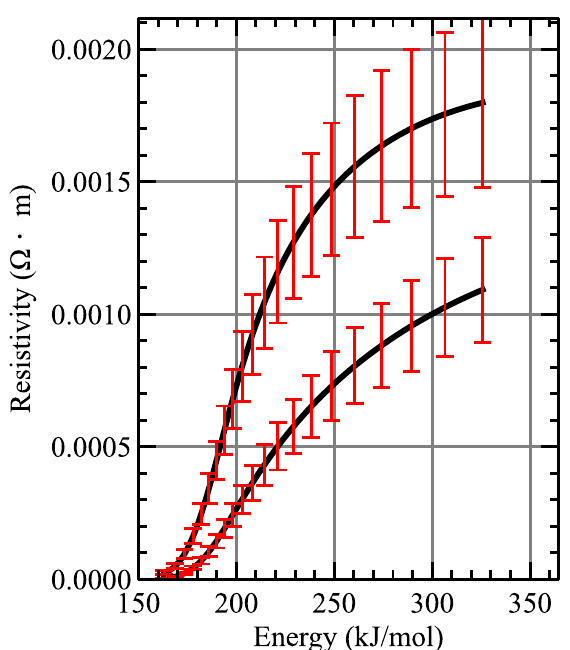
Figure 6. Platinum metal gas resistivity